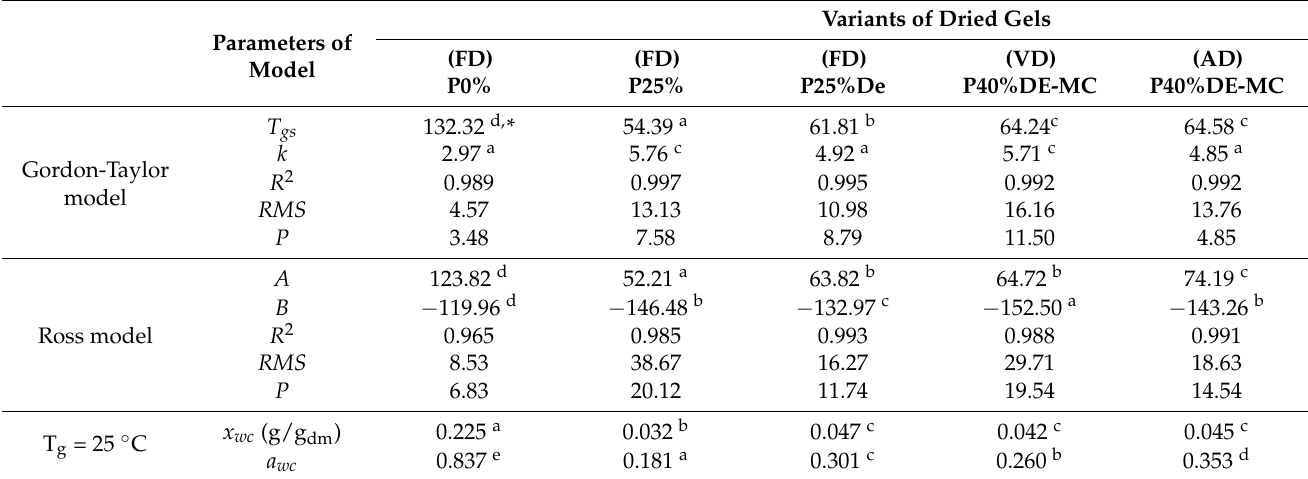
Table 4. Parameter of Ross and Gordon–Taylor models and critical values of moisture content ( x wc ) and water activity a wc at a temperature of 25 °C.